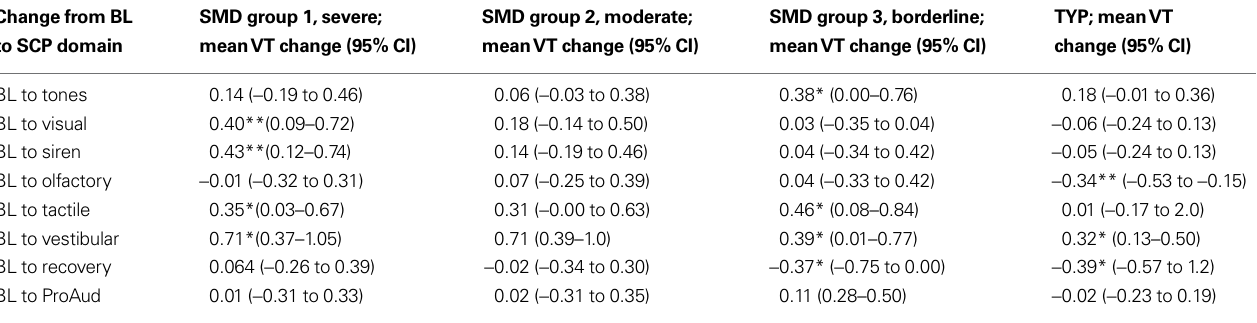
Table 5 | Mean change in VT scores for SMD subgroups and TYP groups (95% CI). Change from